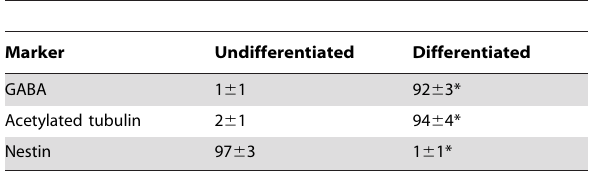
Table 1. Quantification of cells expressing differentiation stage-specific